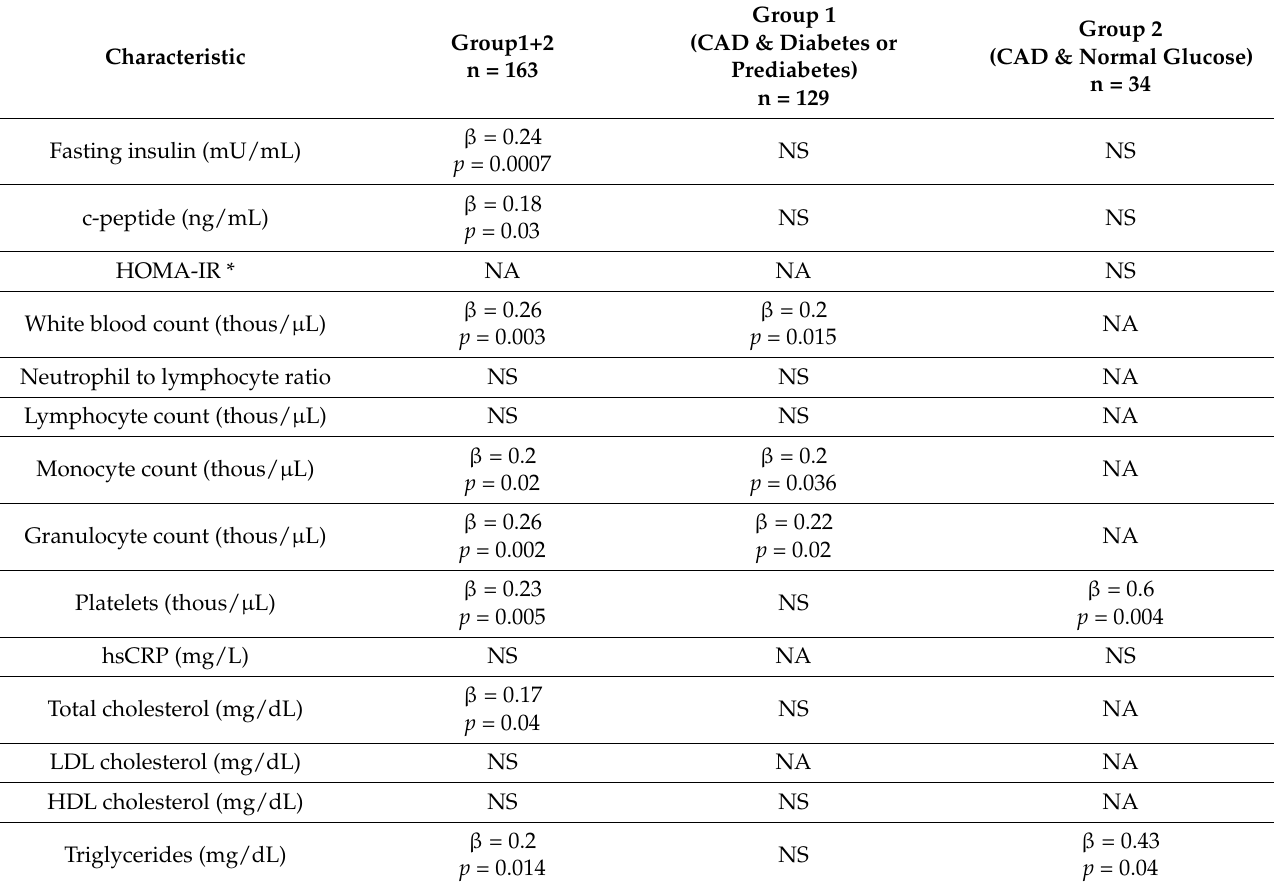
Table 4. Multiple regression for associations between chemerin and other laboratory measurements adjusted for BMI.